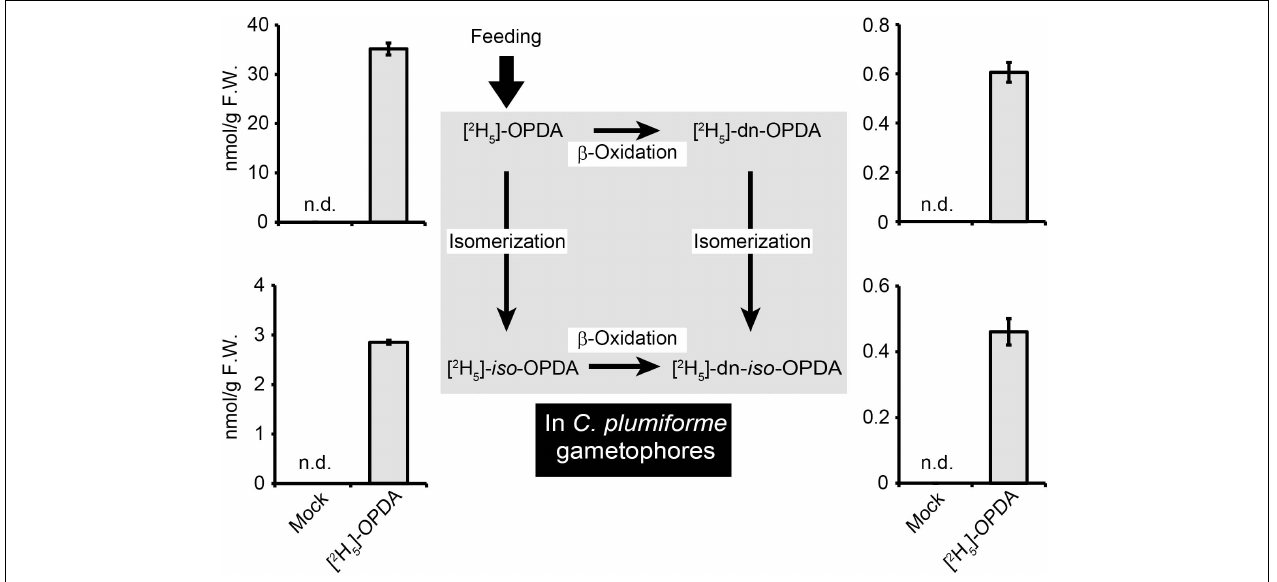
FIGURE 4 | Conversion of deuterium-labeled OPDA [( 2 H 5 )-OPDA] in C. plumiforme gametophores. The values indicate the amount of [ 2 H 5 ]-OPDA, iso -OPDA, dn-OPDA, and dn- iso -OPDA in C. plumiforme gametophores after [ 2 H 5 ]-OPDA treatment at 25 µ M ( n = 3). Mock samples were treated with BCDATG liquid media containing 0.5% (v/v) dimethyl sulfoxide as a negative control. The arrows indicate the proposed biosynthetic pathways in M . polymorpha.